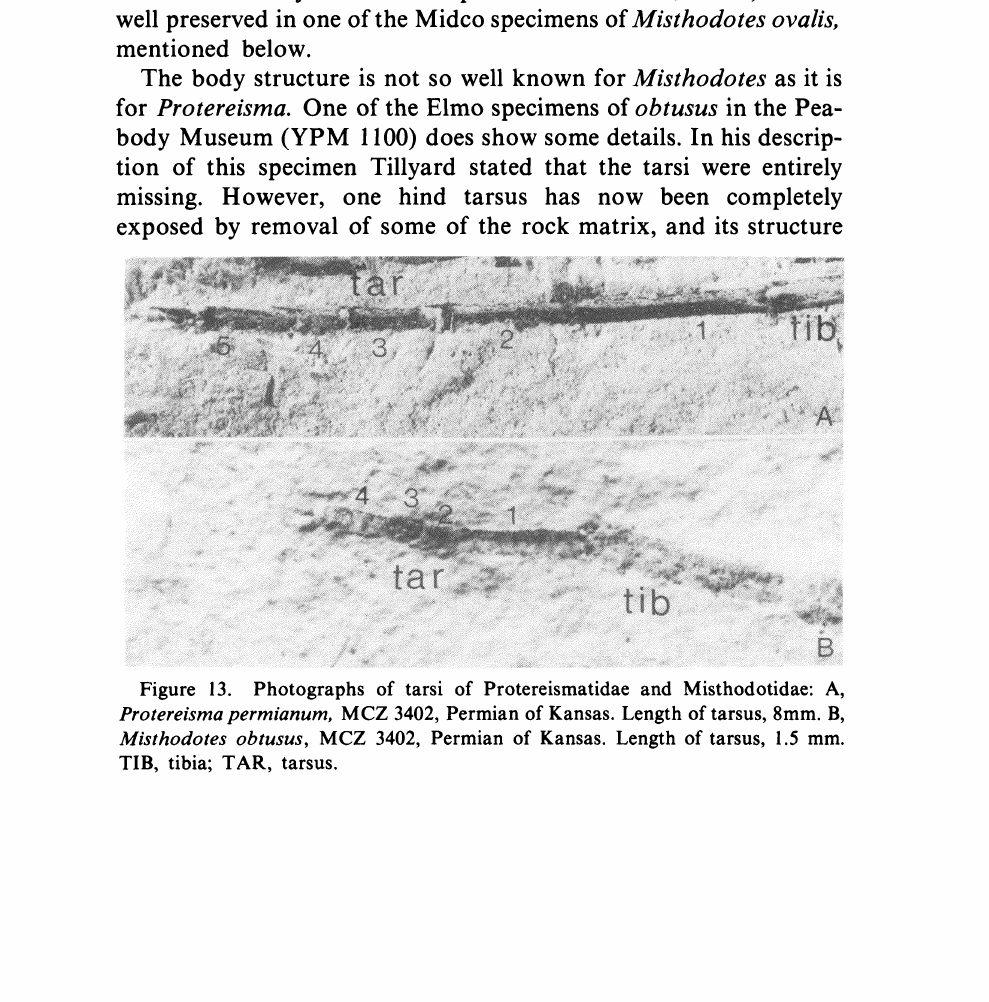
Figure 13. Photographs of tarsi of Protereismatidae and Misthodotidae: A, Protereisma permianum, MCZ 3402, Permian of Kansas. Length of tarsus, 8mm. B, Misthodotes obtusus, MCZ 3402, Permian of Kansas. Length of tarsus, 1.5 mm. TIB, tibia; TAR,